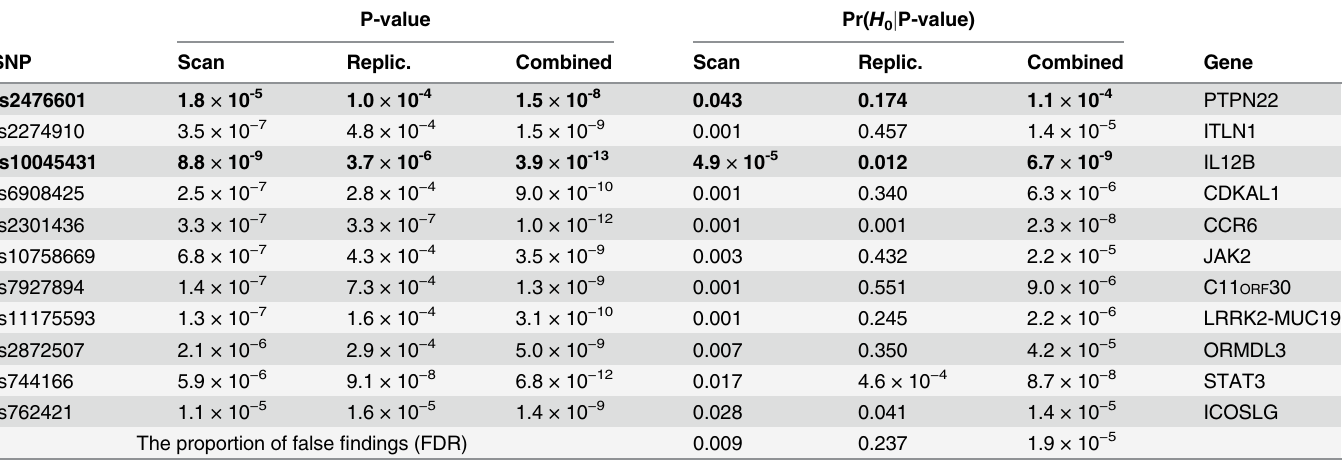
Table 4. P-values reported for the newly identified loci for Crohn ’ s disease in Barrett et al. and the corresponding posterior probabilities of the null hypothesis. Rows highlighted in bold correspond to the maximum and minimum Scan P-values. P-value Pr( H 0 j P-value) SNP Scan